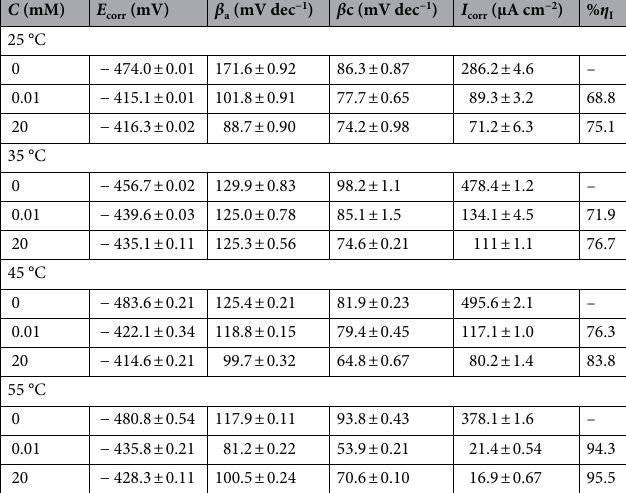
Table 5. Potentiodynamic polarization parameters for MS at diverse temperatures in 5% HCl solution in the absence and presence of varying concentrations of expired Ampicillin drug. “ ± ” shows the standard deviation of three